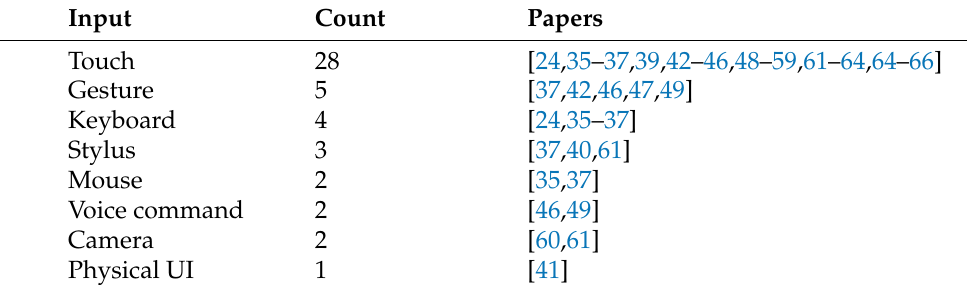
Table 4. Types of input used for improving images on touchscreen